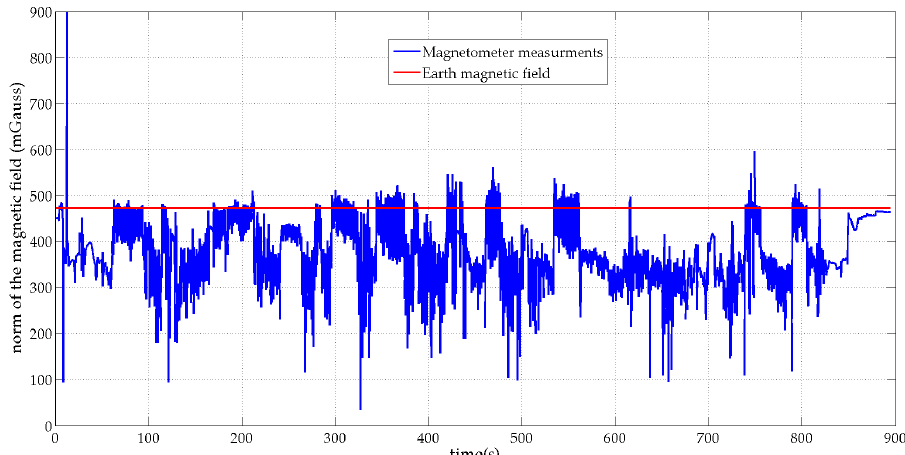
Figure 3. Norm of the MIMU’s acceleration vector (blue) and the Earth gravity field (red).